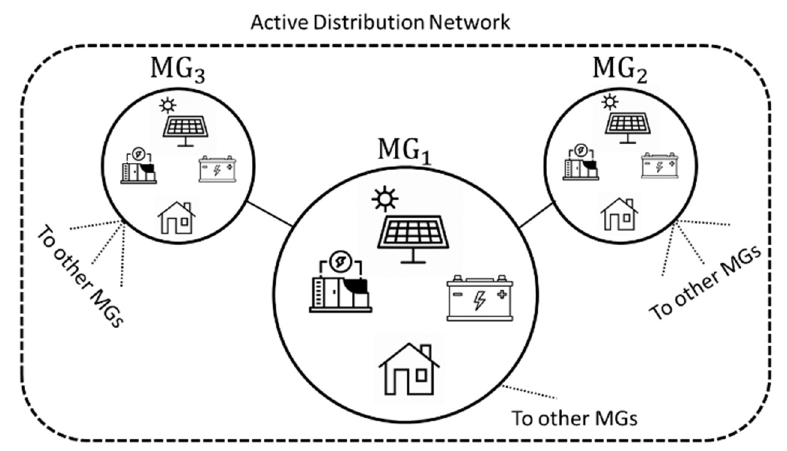
Figure 1. Multiple-MG Distribution Network .